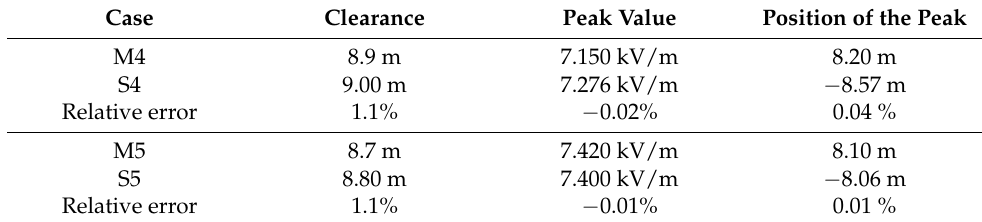
Table 4. Comparison of the measurement and the simulation.